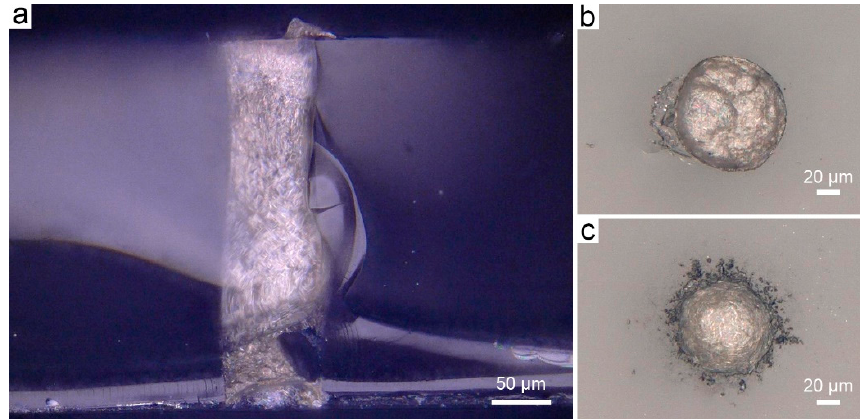
Figure 6. ( a ) The optical magnified cross-sectional image of a TGV filled with the 30 wt% silver nanowires ECAs. ( b ) and ( c ) show that the top and bottom of a fully filled TGV are flat and leveled with the substrate surface.